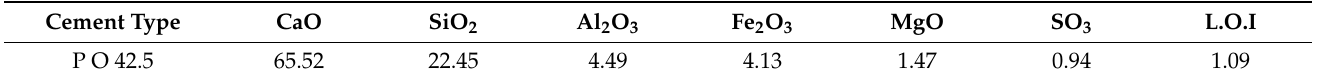
Table 1. Chemical composition of cement